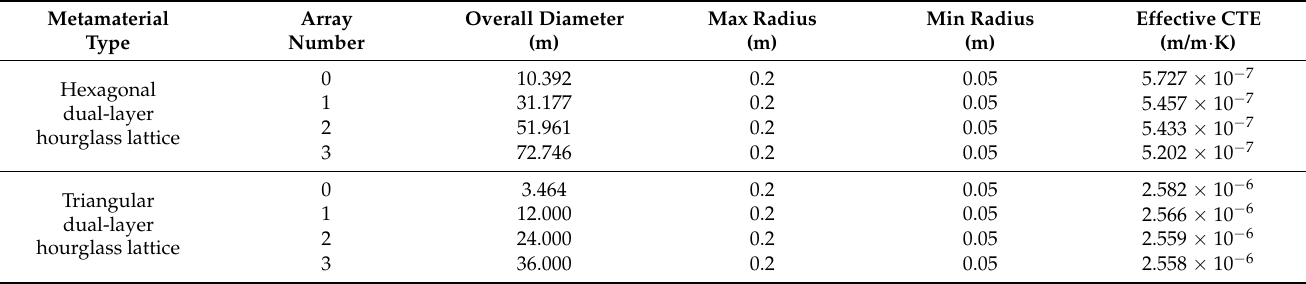
Figure 10. Thermal deformation of triangular hourglass lattice: ( a ) N = 0, CTE = 2.582 × 10 − 6 m/(m · K); ( b ) N = 1, CTE = 2.566 × 10 − 6 m/(m · K); ( c ) N = 2, CTE = 2.559 × 10 − 6 m/(m · K); ( d ) N = 3, CTE = 2.558 × 10 − 6 m/(m · K). Table 2. Results of effective CTE in the thickness direction under different circular